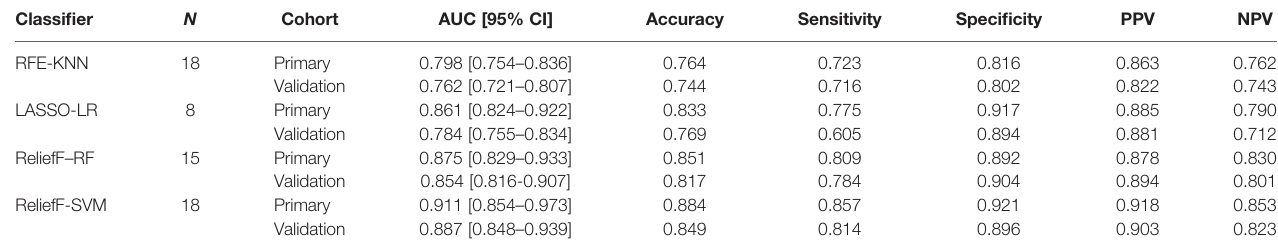
TABLE 4 | The best performance of four radiomics models in the primary and validation cohorts.